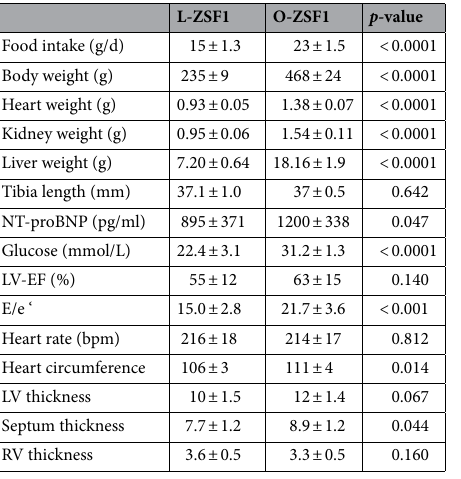
Table 1. Characteristics of O-ZSF1 and L-ZSF1 at 20 weeks of age. LV-EF—left ventricular ejection fraction, E/e’—ratio of mitral peak velocity of early filling (E) to early diastolic mitral annular velocity ( E ’), bpm—beats per minute, LV—left ventricle, RV—right ventricle, NT-proBNP—N terminal B natriuretic peptide. Mean and standard deviation are given. P -value was calculated using Mann–Whitney-U-Test. Histological measurements are given in arbitrary